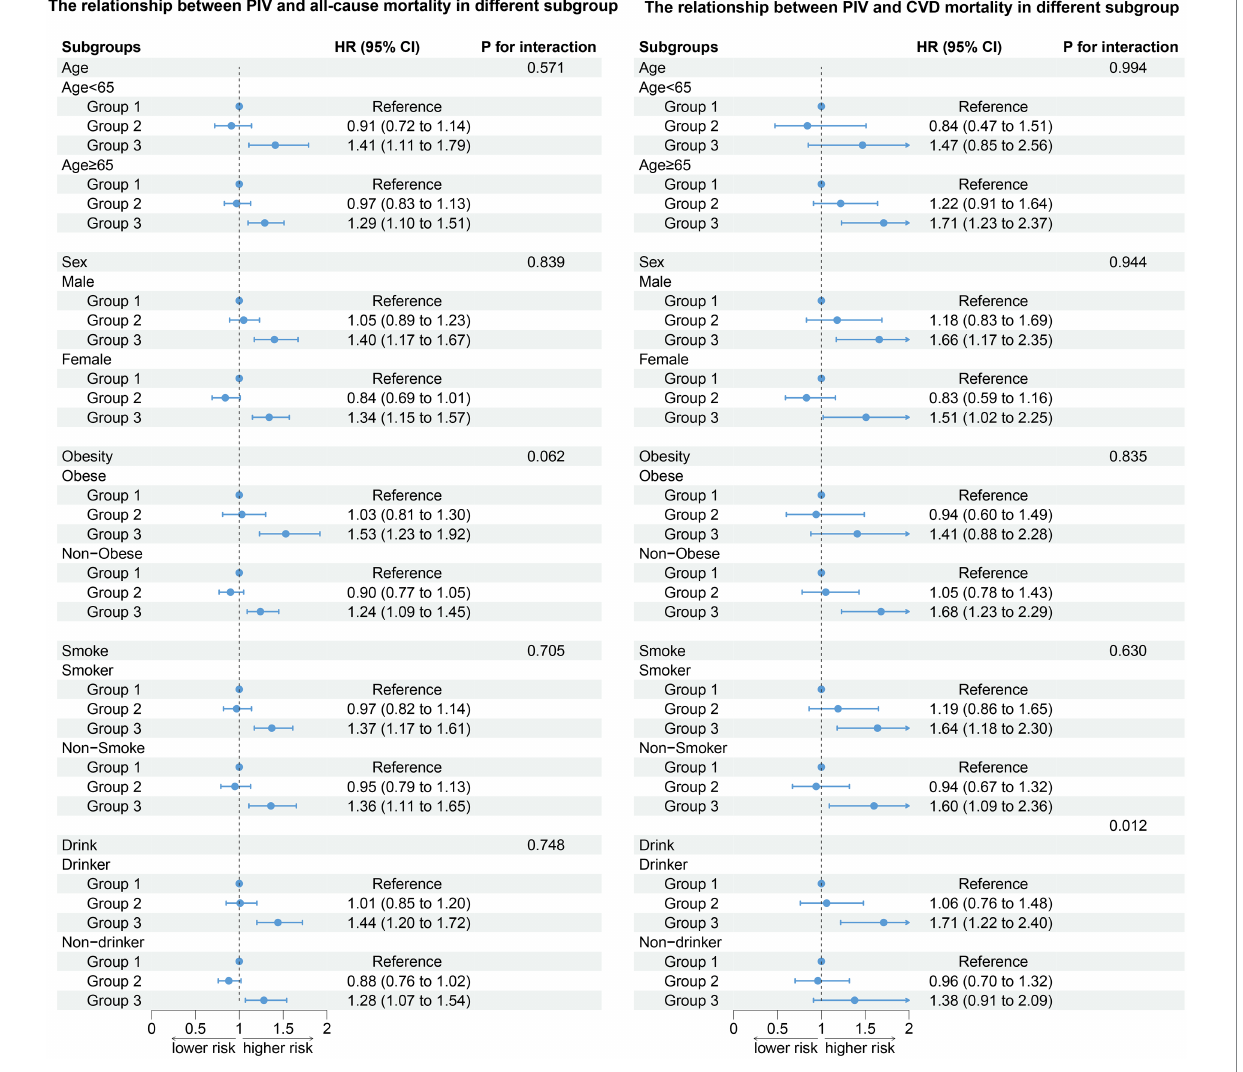
FIGURE 4 Association between PIV and all-cause and CVD mortality by selected subgroups